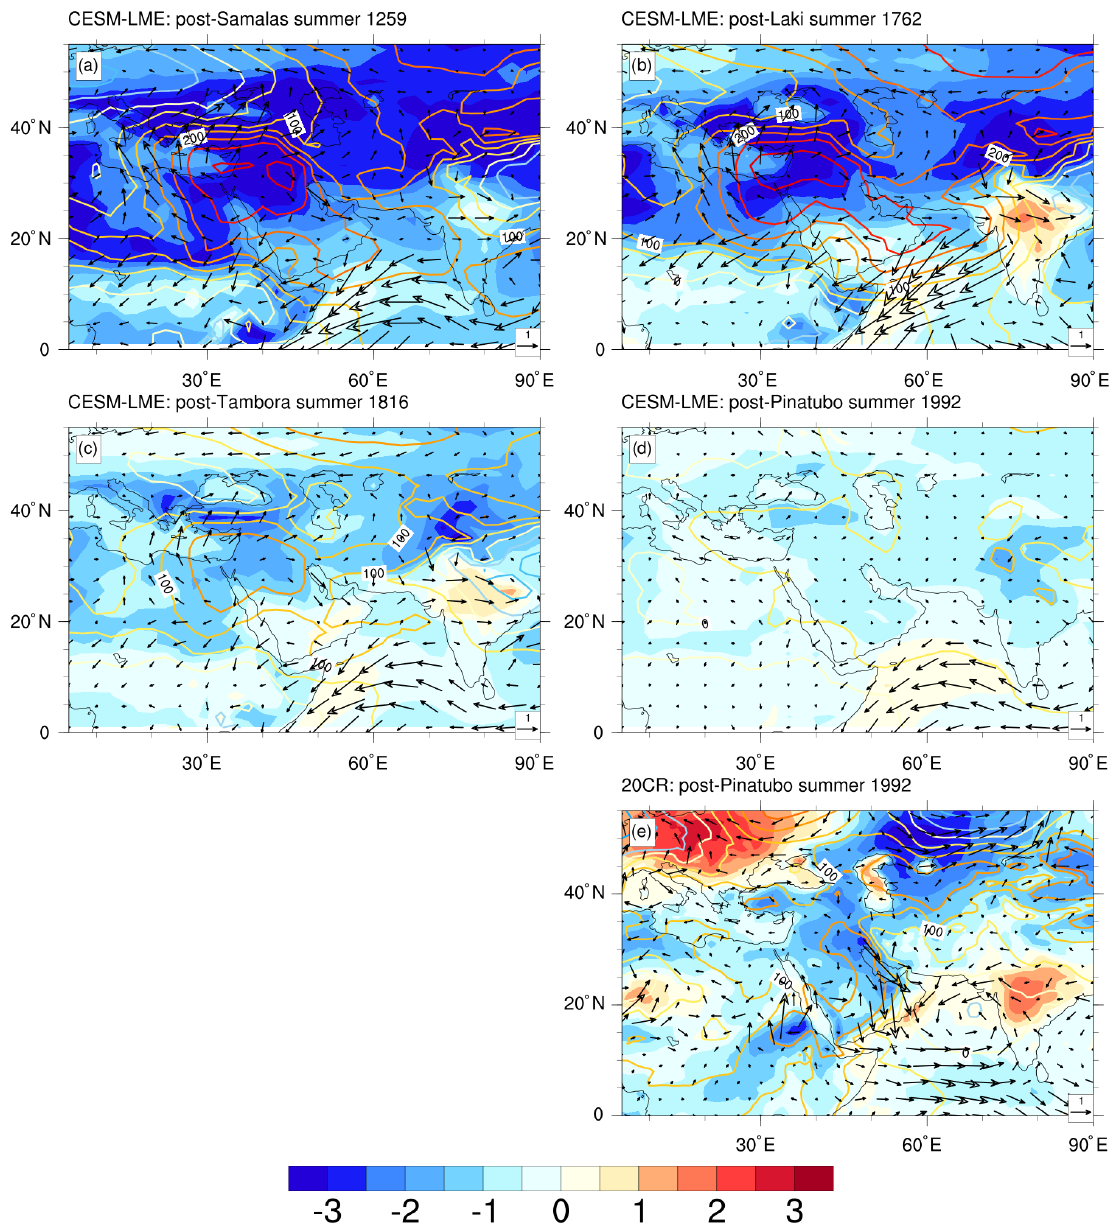
Figure 5. Anomalies of surface temperature (K; shaded), 10m winds (ms − 1 ; arrows) and SLP (Pa; contours) in the post-eruption summers (JA) following Samalas, Laki, Tambora and Pinatubo. Panels (a) – (c) from CESM-LME and panel (e) from 20CR. Anomalies relative to the average 5 years before the eruption year (see Table 1). No significance test is overlaid. See Fig. S2 for all eruptions listed in Table